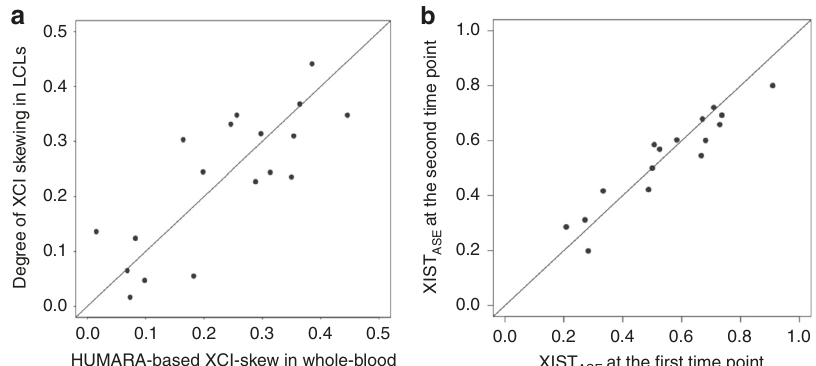
Fig. 1 XIST ASE is a reproducible and accurate proxy of XCI skewing levels. a Scatter plot showing the comparison between the XCI skewing levels in n = 18 whole-blood and LCLs samples quanti fi ed with HUMARA and XIST ASE respectively. b Scatter plot of the XIST ASE at time point 1 and at time point 2 in n = 16 whole-blood samples. Diagonal line indicates perfect concordance in the data ( ρ = 1). HUMARA human androgen